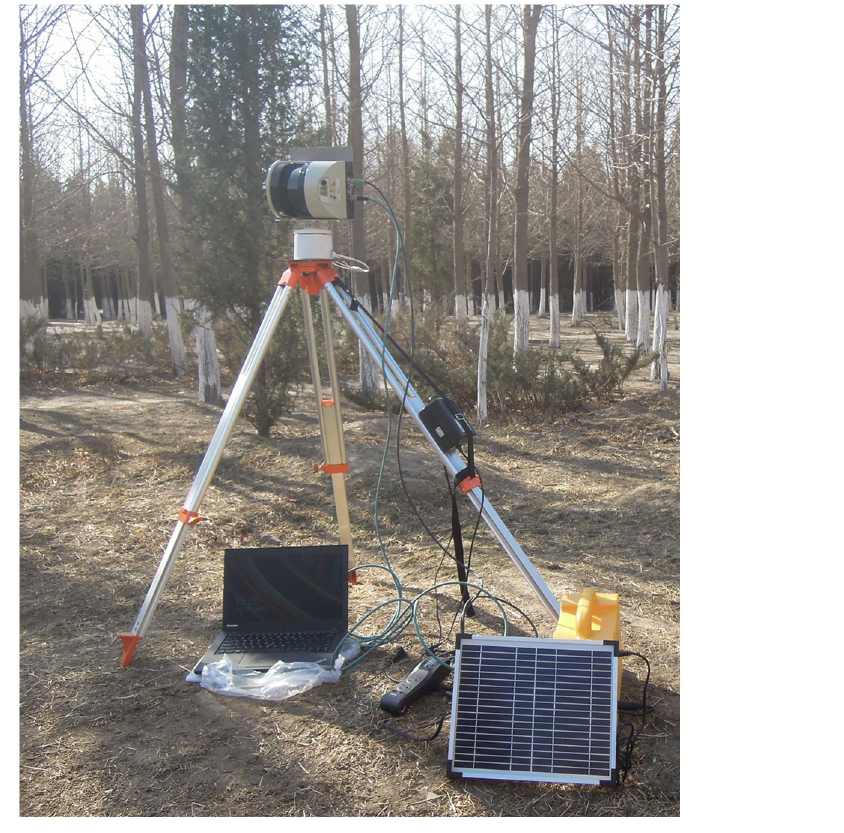
Fig 2. Picture of the BEE scanner at the field